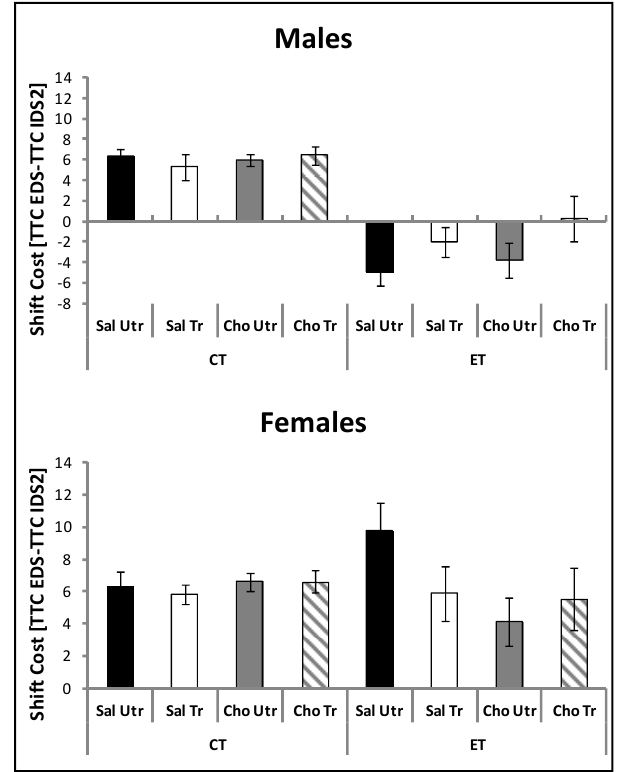
Figure 4. EDS shift cost for each group. ET males (top panel) did not form an attentional set, and this was not reversed by choline, working memory training or the combination of the two. Females (bottom panel) formed an attentional set irrespective of prenatal or postnatal conditions. Bars represent the Mean ± SEM, n = 7–9 per group. Abbreviations as in Figure 2.